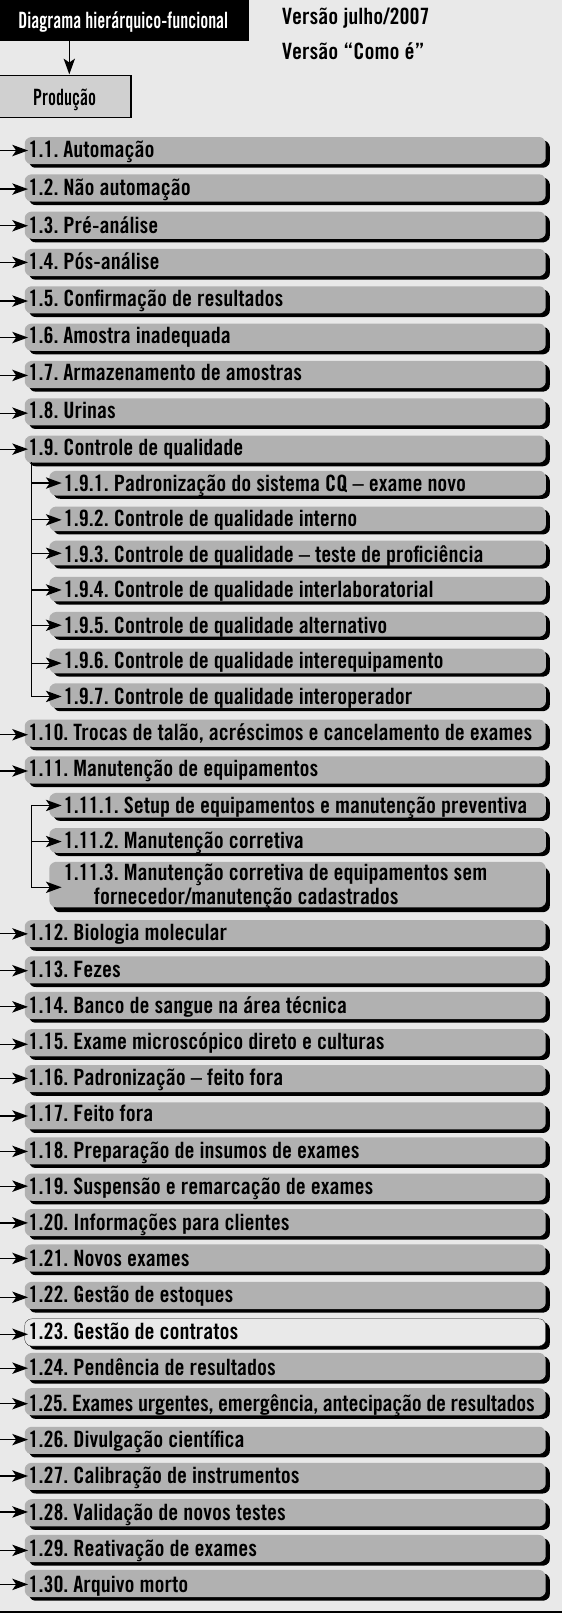
Figura 1 – Diagrama hierárquico-funcional dos processos identificados na central técnica CQ: controle de